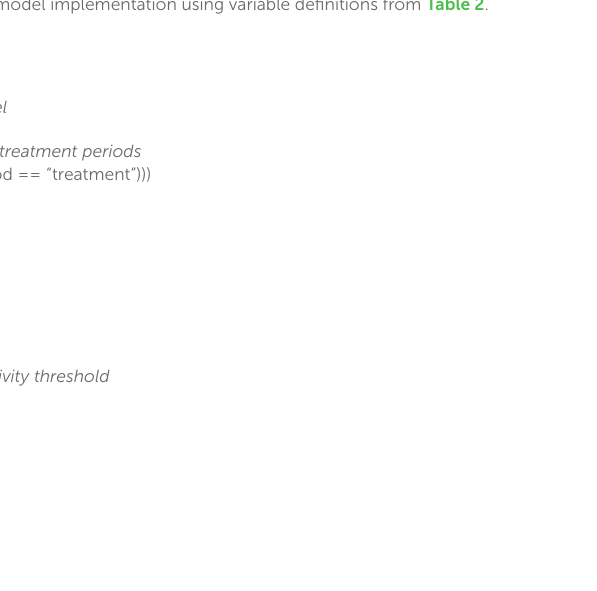
BOX1 Pseudocode representation of daily water level model implementation using variable definitions from Table 2 . # Water levels are started at ‘full’ conditions WL[1] = WL con